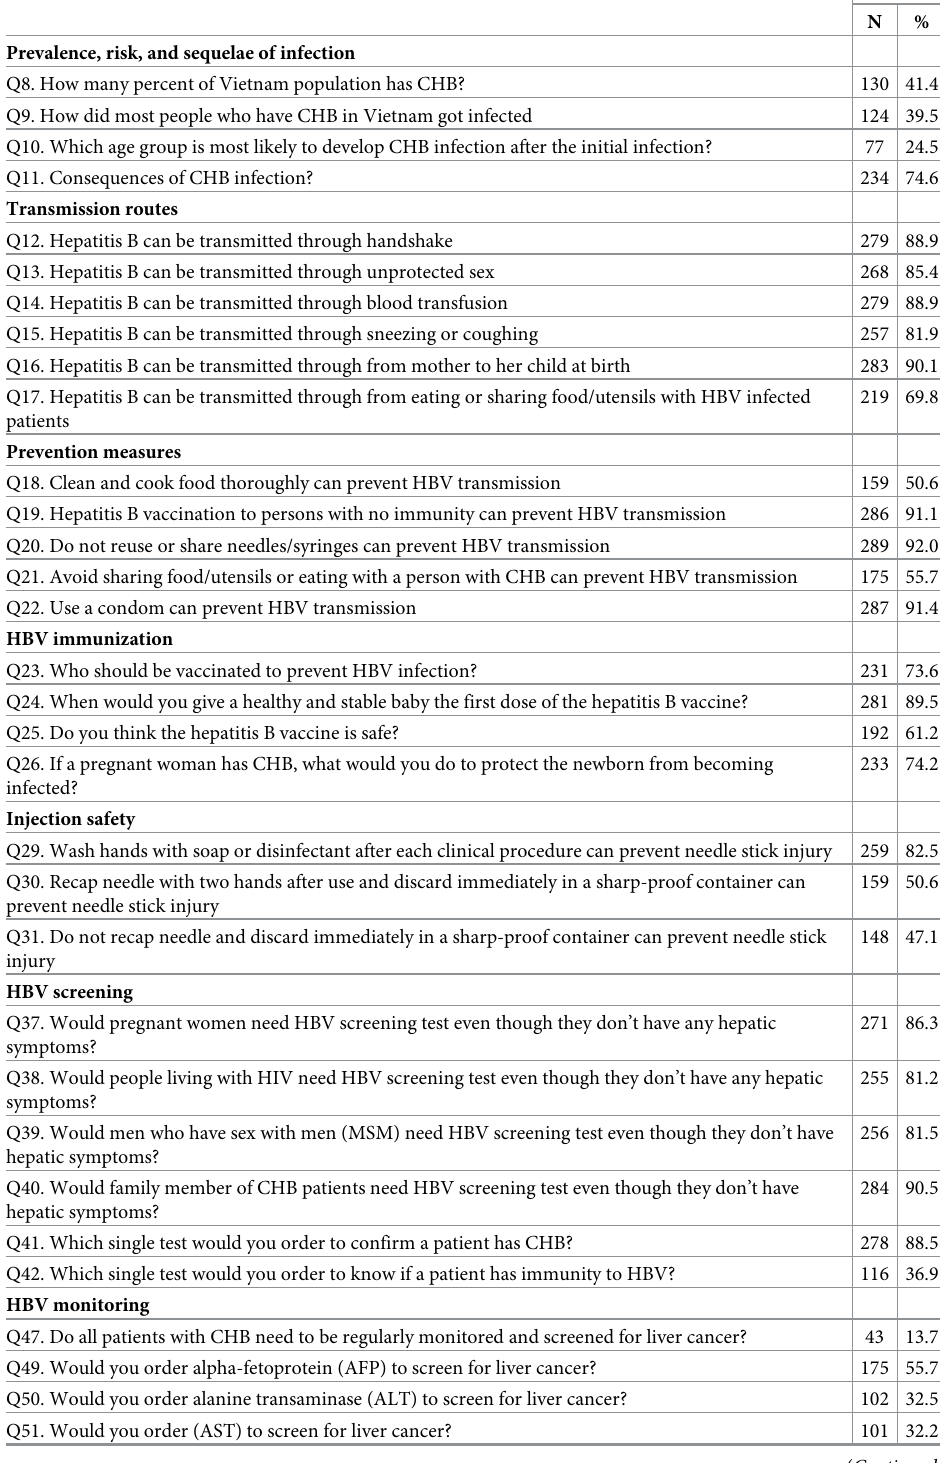
Table 2. Distribution of correct responses to HBV risk, prevention, and management (N =